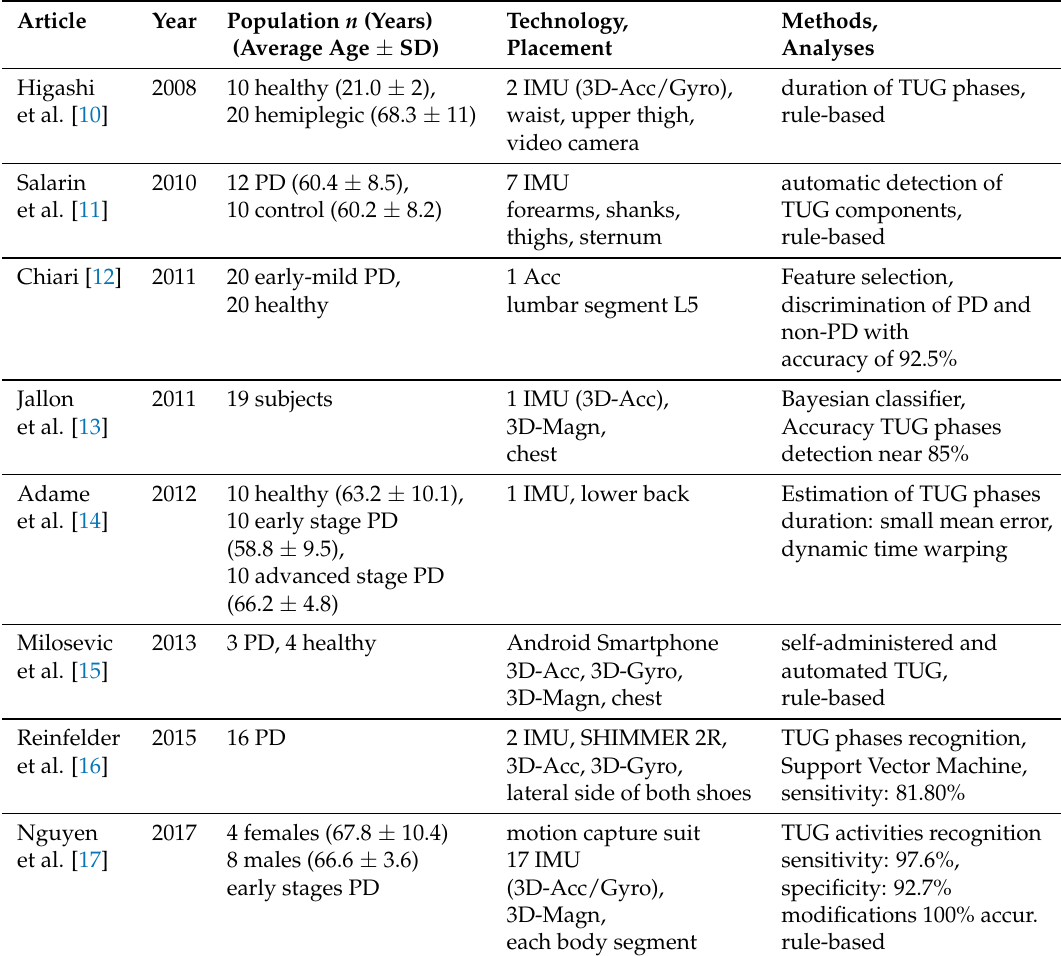
Table 1. Selection of studies that used inertial sensors for TUG analyses. The study population, as well as the placement of the IMU and the analyses method are listed in detail. Parkinson’s disease is abbreviated as PD; Accelerometer (Acc); Gyroscope (Gyro); Magnetometer (Magn); instrumented TUG